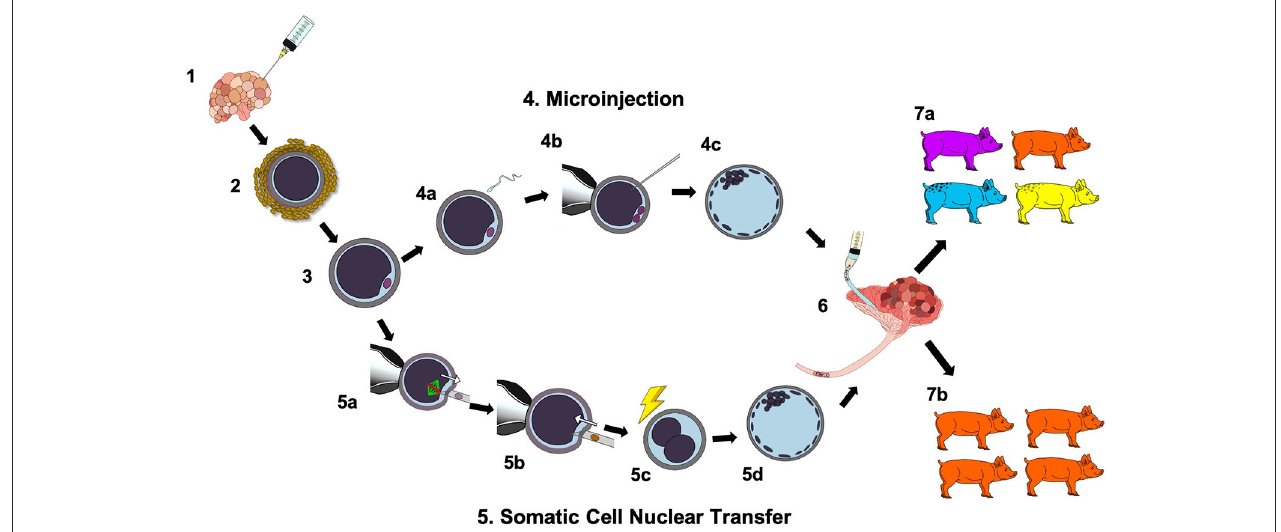
FIGURE 1 | Schematic of in vitro production of porcine embryos, manipulation procedures, and surgical transfer to obtain live-born piglets. (1) Follicular contents are aspirated from follicles (3–6mm in diameter) by using an 18-gauge needle attached to a 10-mL disposable syringe. (2) Cumulus-oocyte complexes (COCs) with at least two layers of cumulus cells to be placed in maturation medium. (3) Oocytes are denuded and are inspected for extrusion of the first polar body (metaphase II), as an indicator of maturation. (4) Microinjection: (4a) Matured oocytes are fertilized in vitro and (4b) zygotes are injected with the CRISPR/Cas9 system. (4c) Zygotes are cultured for 5–6 days to reach the blastocyst stage. (5) Somatic cell nuclear transfer (SCNT): (5a) The first polar body and metaphase plate are extracted from the oocyte. (5b) An edited donor cell is injected into the perivitelline space. (5c) The oocyte and donor cell are electrically fused followed by artificial activation. (5d) The cloned embryo is cultured for 5–6 days to reach the blastocyst stage. (6) The embryos are surgically transferred into the ampullary-isthmic junction of a gilt. (7a) Piglets derived from microinjected embryos have varying edits to the target gene(s) as denoted by different colors. (7b) Cloned piglets have the same mutation(s) as the donor cells used for SCNT as denoted by the same